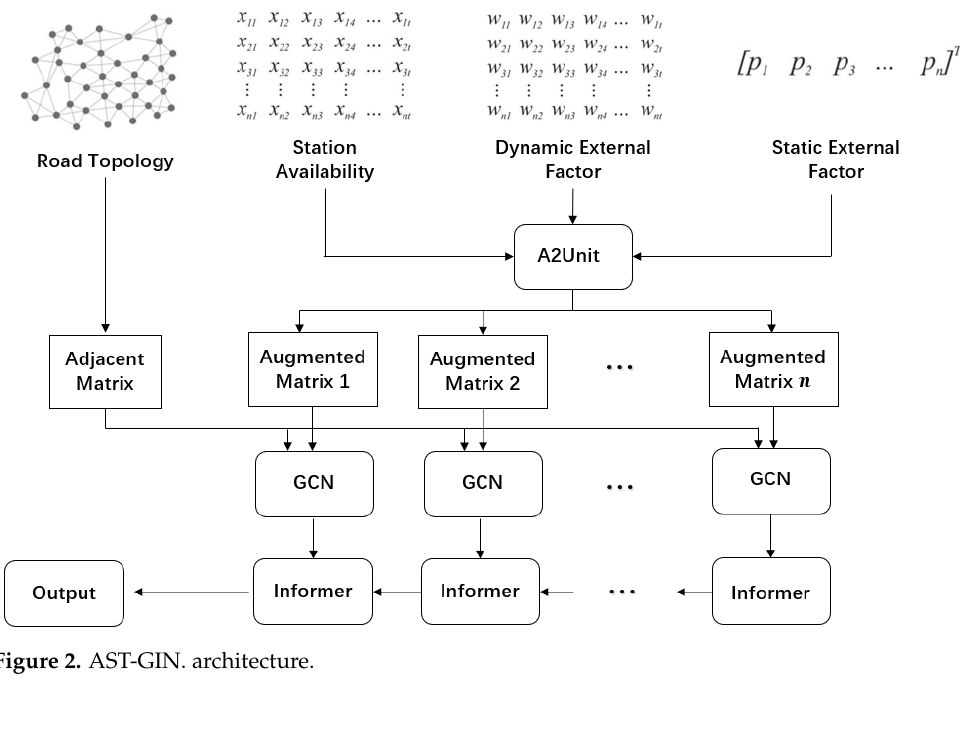
Figure 2. AST-GIN. architecture.